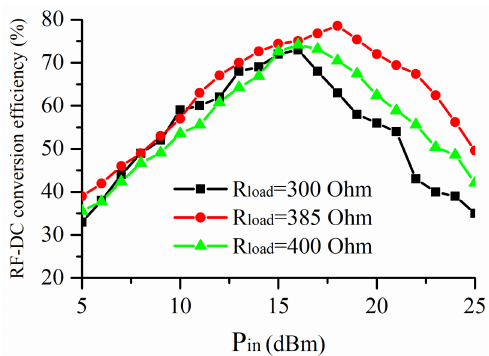
Figure 14. Measured RF–DC conversion efficiency under different loads R load and input power values P in , at port 1.